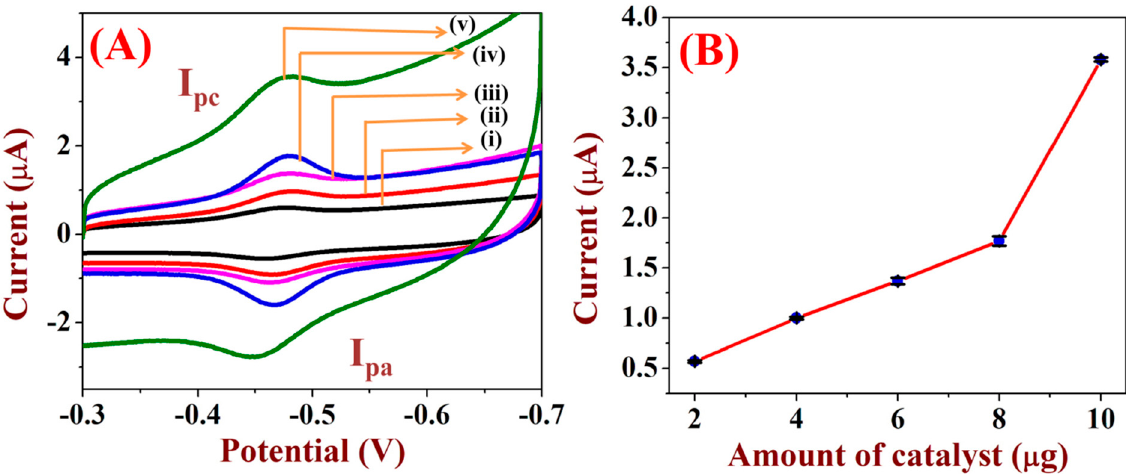
Figure 3. ( A ) CVs were recorded using different FAD/Ti 3 C 2 T x GCE’s which were prepared with different amounts of Ti 3 C 2 T x : (i) 2, (ii) 4, (iii) 6, (iv) 8 and (v) 10 µg. For all the electrodes, electro-deposition of FAD was carried out using 10 nM FAD in 0.1 M H 2 SO 4 for 30 cycles, scan rate = 50 mV/s. ( B ) The non-linear plot shows the relationship between the amount of Ti 3 C 2 T x and the reduction peak currents of FAD (immobilized).